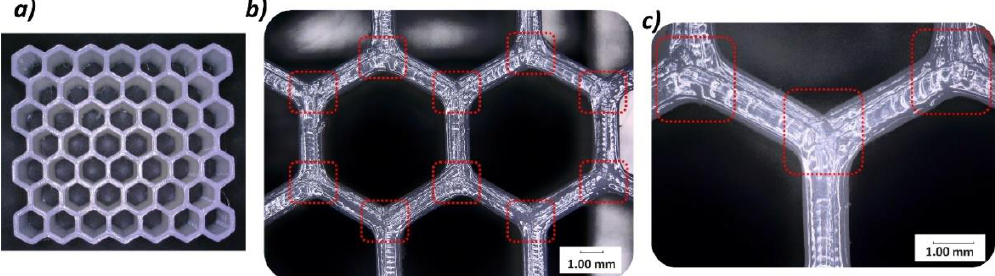
Figure 6. The view of the top surface of 3D printed honeycomb specimen with the use of thermoplastic polyurethane (TPU) material: ( a ) General view, ( b ) with magnitude ×10, ( c ) with magnitude ×20.